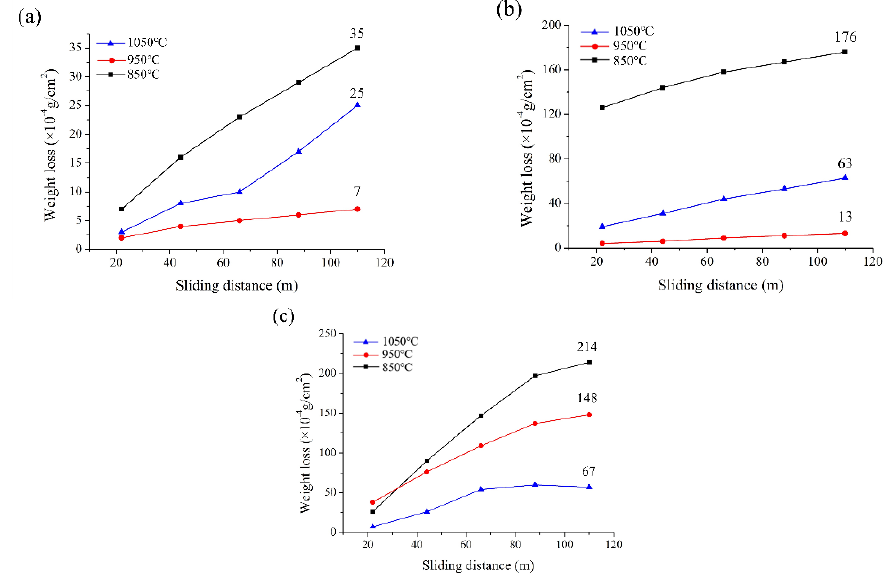
Figure 8. Weight losses of ( a ) T2N8, ( b ) T5N5 and ( c ) T8N2 sintered at various temperatures after wear tests.